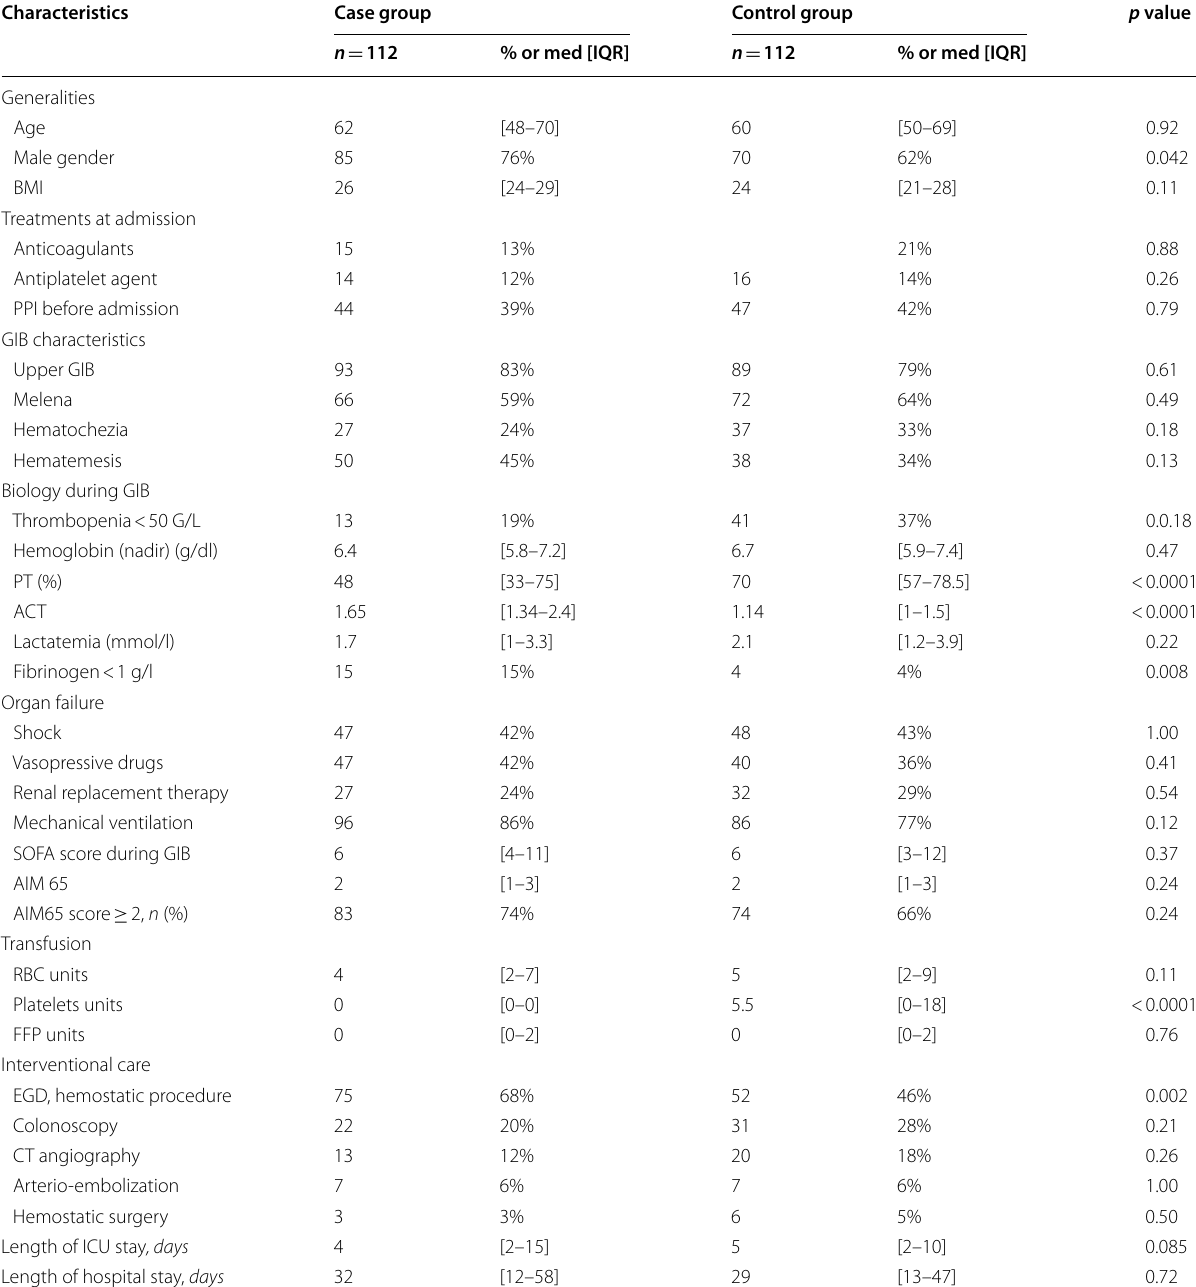
Table 2 Case/control comparison after